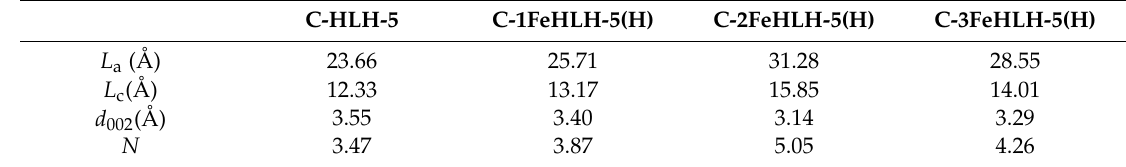
Figure 4. XRD profiles of carbonized chars with different amounts of FeCl 3 additive. Table 4. XRD data of carbonized chars with different amounts of FeCl 3 additive.